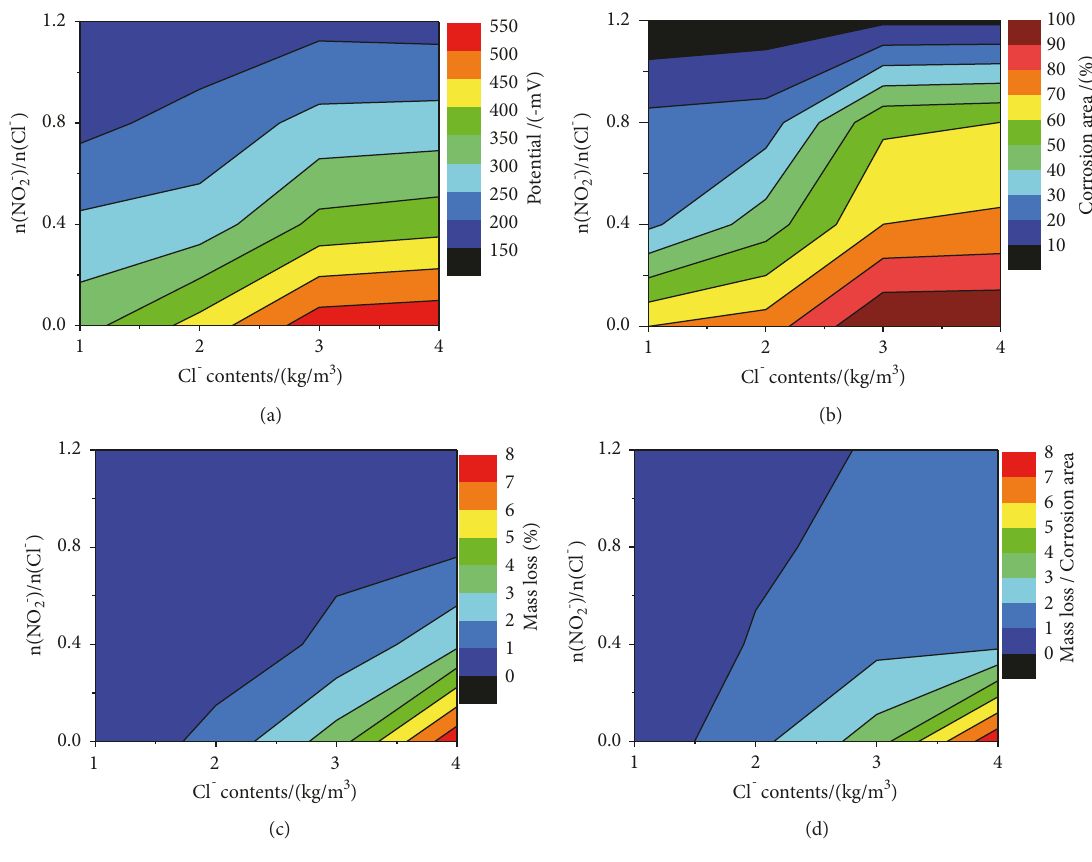
Figure 1: Corrosion parameter of steel bar at 30